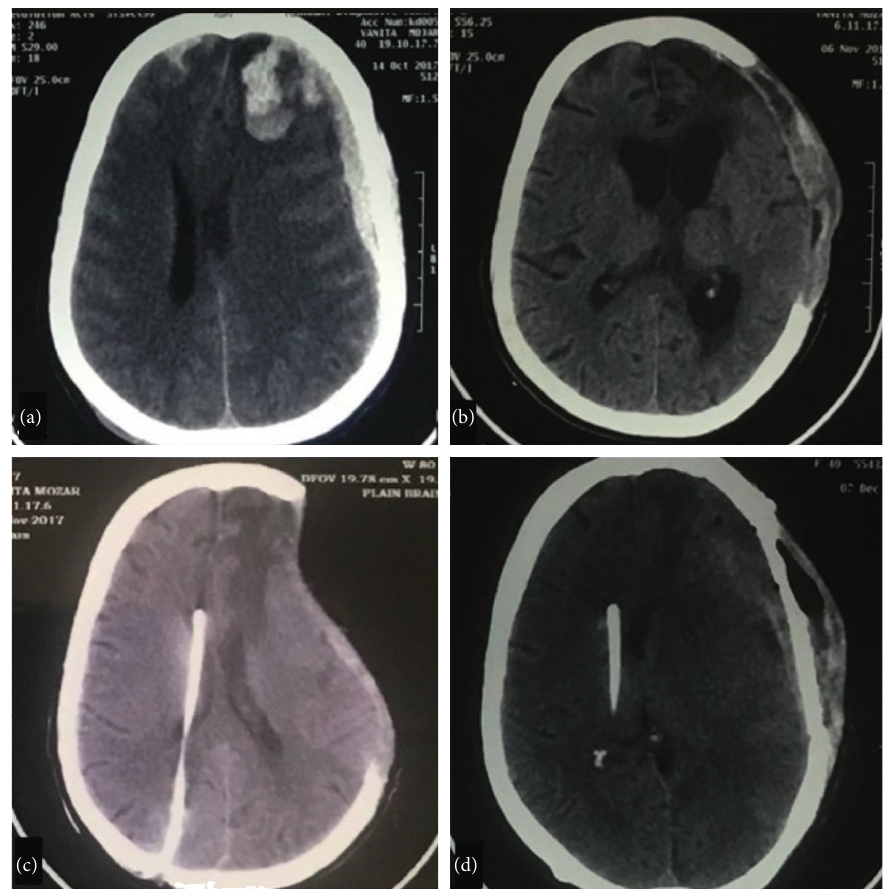
Figure 1: (a) Computed tomography (CT) plain brain, axial view showing hyperdense collection along left subdural plane extending across frontal, temporal, and parietal regions. (b) Computed tomography (CT) plain brain, axial view showing dilated ventricles and herniation of brain from craniectomy site. (c) Computed tomography (CT) plain brain, axial view showing VP shunt in situ and excessively sunken brain at craniectomy site causing midline shift to right side. (d) Computed tomography (CT) plain brain, axial view on postoperative day 1, showing cranioplasty using flattened bone. Also, partial resolution of midline shift can be